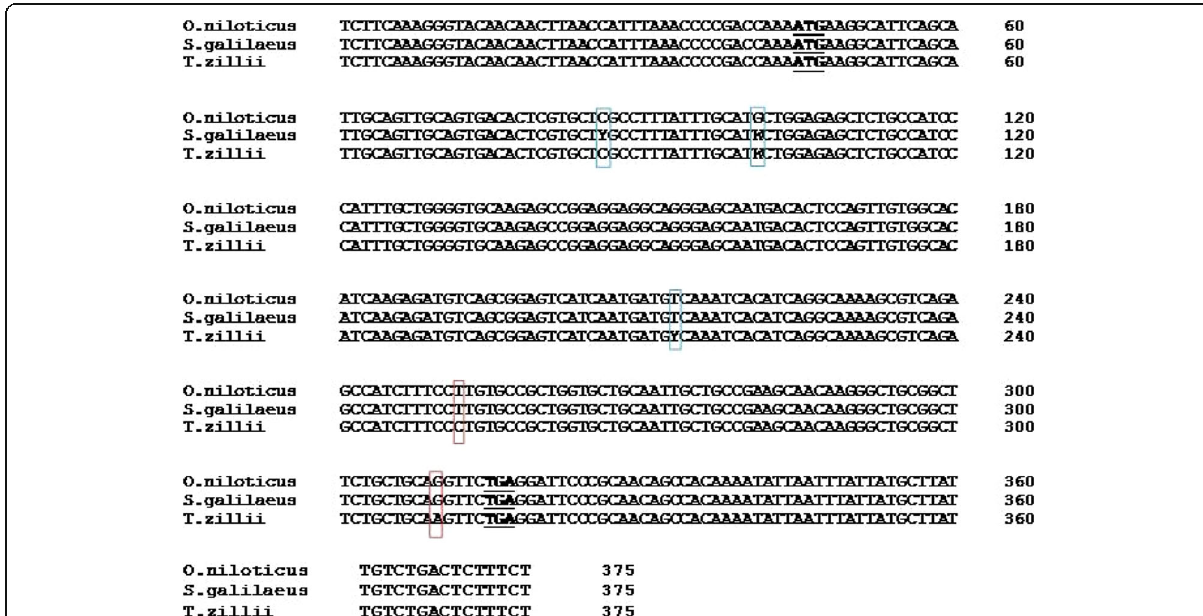
Fig. 6 cDNA sequence of hepcidin 2 gene. The coding regions start codon ATG and termination codon TGA are both bold and underlined. The alignment of nucleotide sequences of O. niloticus , T. zillii , and S. galilaeus shows two SNPs at nt 252 (T/C) and nt 310 (G/A) (in red box) and different genotypes for each species (in blue